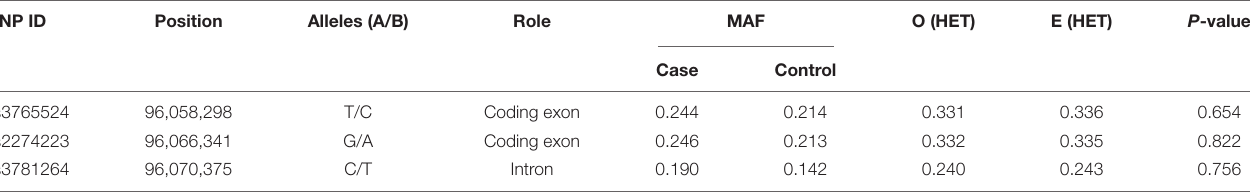
TABLE 2 | Basic information of three SNPs in PLCE1 on 10q23.33.